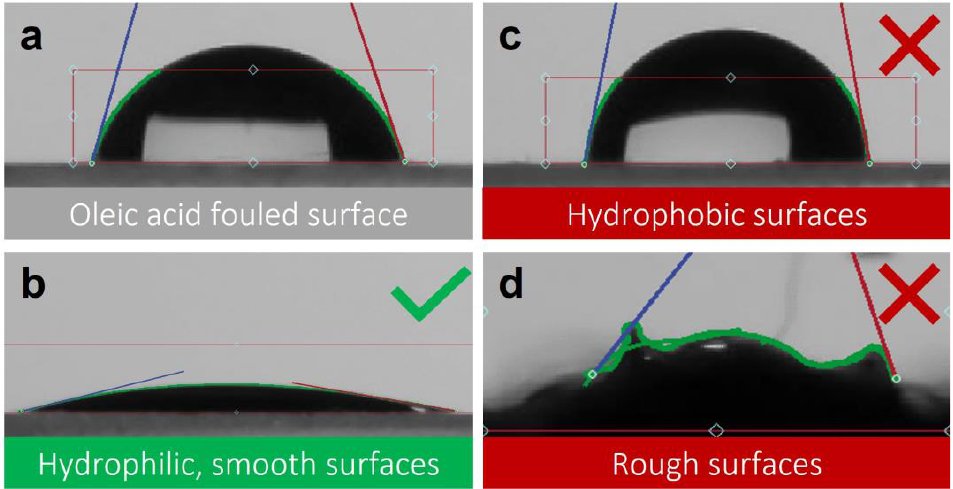
Figure 5. Water droplets on top of different surfaces: a surface fouled with oleic acid ( a ), a clean, smooth and hydrophilic surface ( b ), a clean and hydrophobic surface ( c ) and a clean and rough surface ( d ). For rough surfaces, the water contact angle cannot be measured, and for the hydrophobic surface, the standard cannot be used, which is indicated by the red color and crosses. The green color and checks indicate that hydrophilic, smooth surfaces are suitable for this standard.